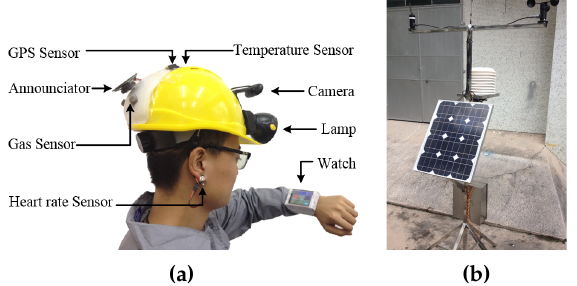
Figure 5. ( a ) Sensor-embedded wearable wireless devices: smart helmet and wrist watch; ( b ) static wireless sensor node. The smart helmet is sensor-embedded, and it works with the wrist watch to dynamically detect toxic gases. The static node is supported by solar energy and enables persistently measuring the concentration of gases in the air, e.g., CO, SO 2 and CH 4 , and other environmental information, e.g., wind speed, humidity and